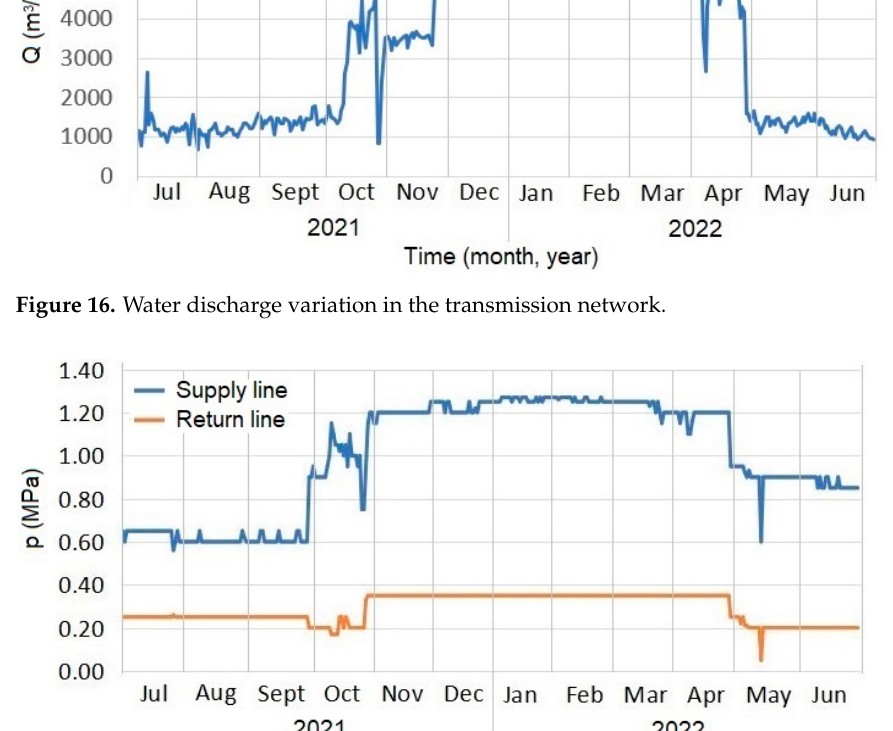
Table 8. Node’s number and recovered energy in the heating season.